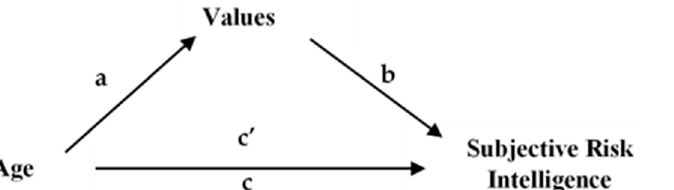
Figure 1. Mediation model. Note: a = effect of age on values (openness to change, self-transcendence, self-enhancement, conservation); b = effect of values on risk intelligence; c = total effect of age on risk intelligence when values are not included as mediators; c’ = direct effect of age on risk intelligence when values are included as mediator.